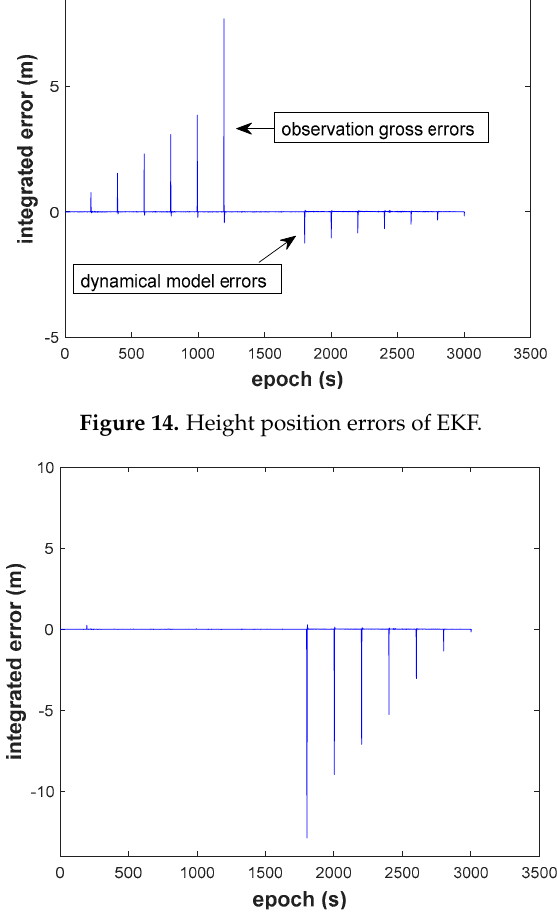
Figure 15. Height position errors of RKF.